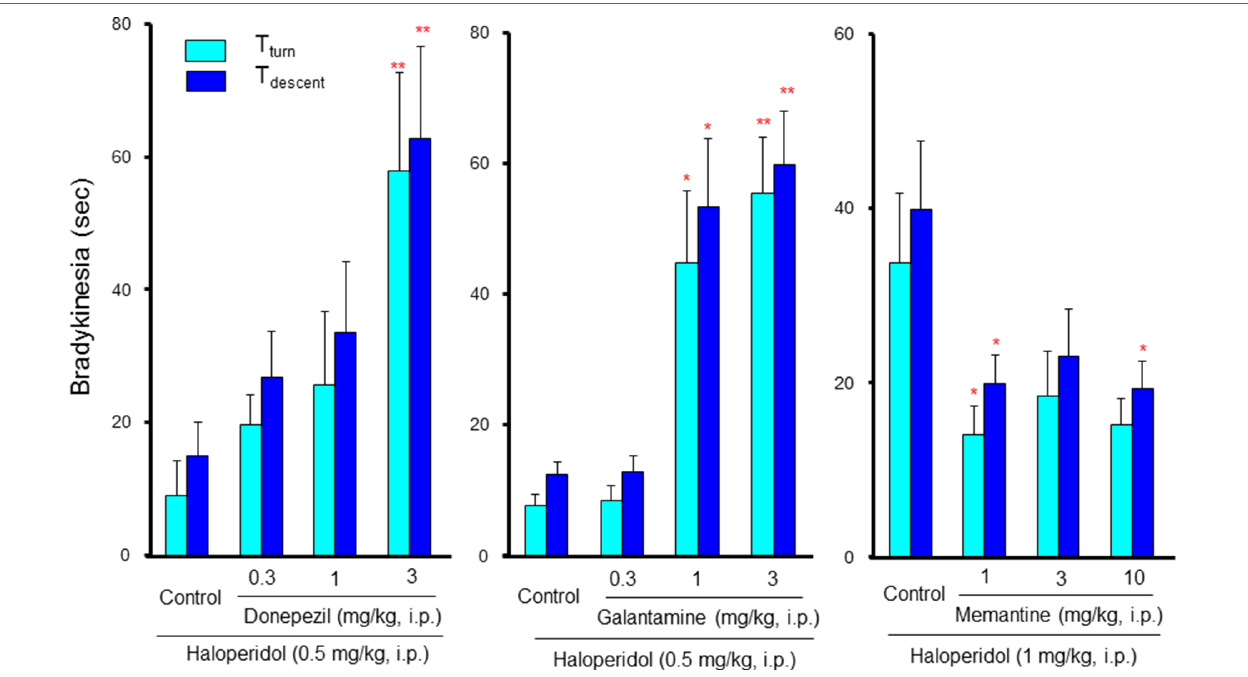
FIGURE 6 | Interactions between anti-Alzheimer’s disease drugs and antipsychotics in induction of extrapyramidal side effects (EPS). Bradykinesia was estimated by the pole test, where mice were placed head-upward at the top of a pole (45 cm in height) and the time for mice to rotate downward (T turn ) and to descend to the floor (T descent ) was measured (Ohno et al., 2008a). Bradykinesia was evaluated as the prolongation of T turn or T descent Values. Although low dose (0.5 mg/kg) of haloperidol showed marginal effects in the pole test, combined treatment with cholinesterase inhibitors, donepezil, and galantamine, markedly potentiated haloperidol- induced bradykinesia in a synergistic manner. By contrast, the NMDA antagonist, memantine, significantly reduced bradykinesia induced by a high dose (1 mg/kg) of haloperidol. * P <0.05, ** P ,0.01; Significantly different from the control values. This figure is partly quoted and arranged from J. Pharmacol. Sci. 127, 439,